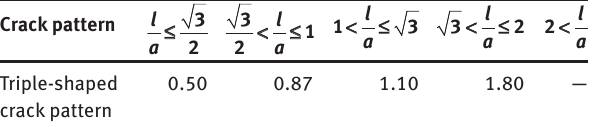
Table 2: Selection of the ratio l / a for the triple-shaped crack pattern. Crack pattern